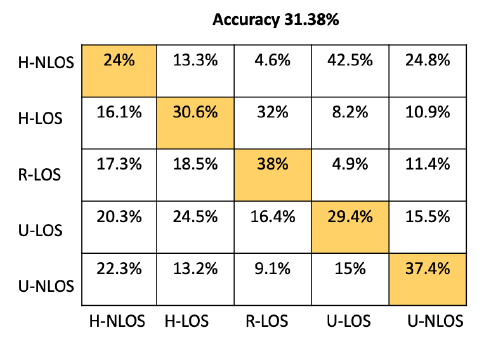
Figure 9. Confusion matrix for GNB based on LTS approach.